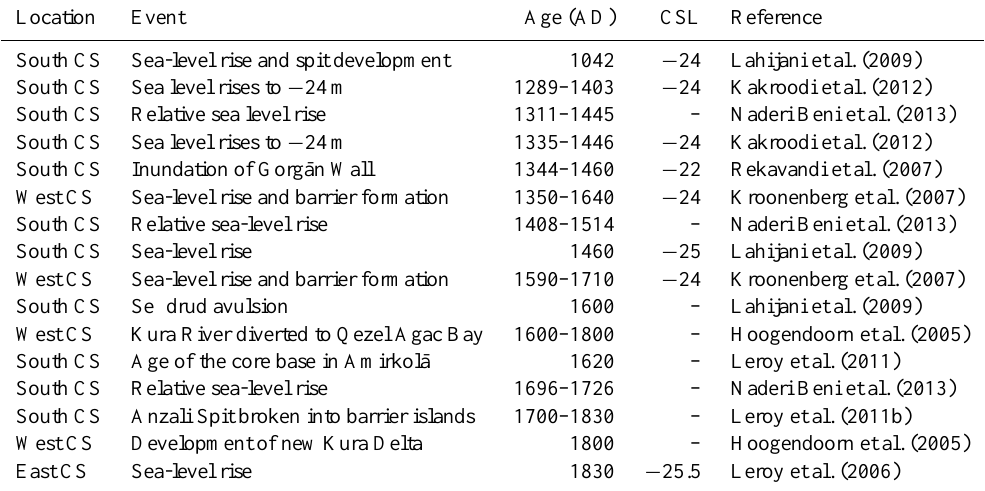
Table 1. Geological findings on the Caspian sea-level (CSL) changes in the Late Holocene. The sea level position is inserted where the data are